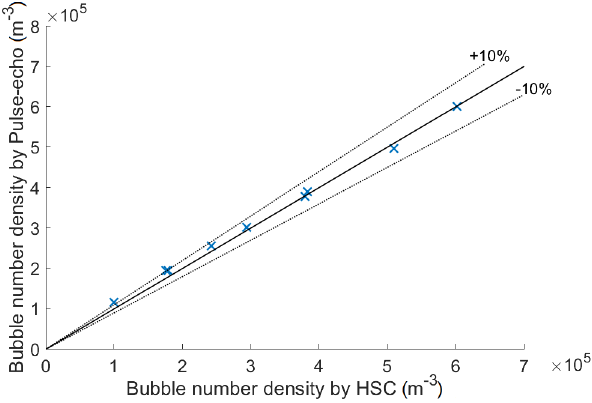
Figure 9. Bubble number densities by pulse-echo and HSC averaged over each measurement case. Table 3. Bubble number densities by pulse-echo and HSC averaged over each measurement